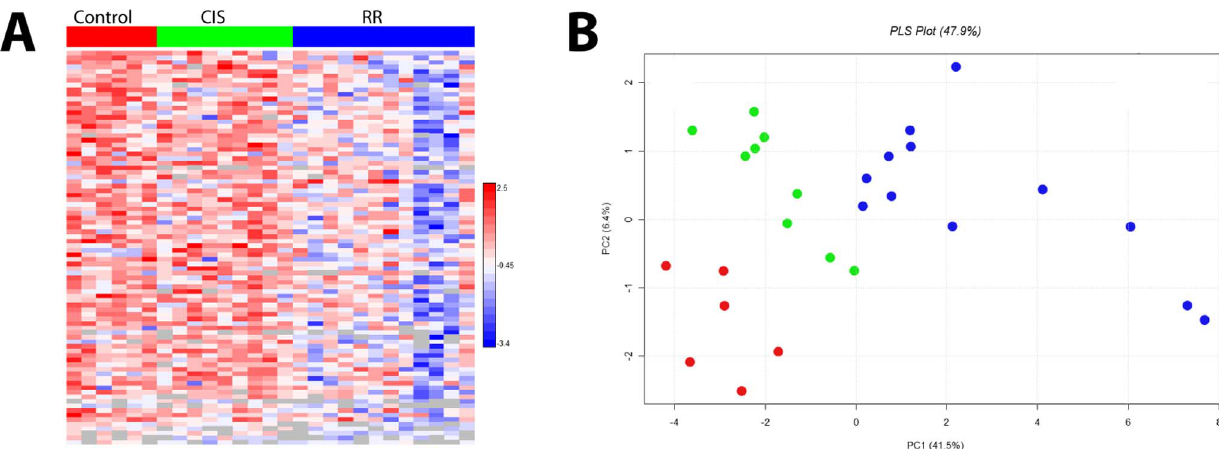
Figure 2. Label-free quantification of CSF proteins identified in patient and control samples. A) Following the 1D LC-MS analysis of immunodepleted CSF samples we identified peptides referable to 86 proteins that show significant difference in abundance by ANOVA (p-value , 0.05) (Table S2). B) Partial least squares analysis of quantified proteins demonstrates that these three groups (control, first-attack CIS MS, RR-MS) can be distinguished from one another considering the CSF proteome.